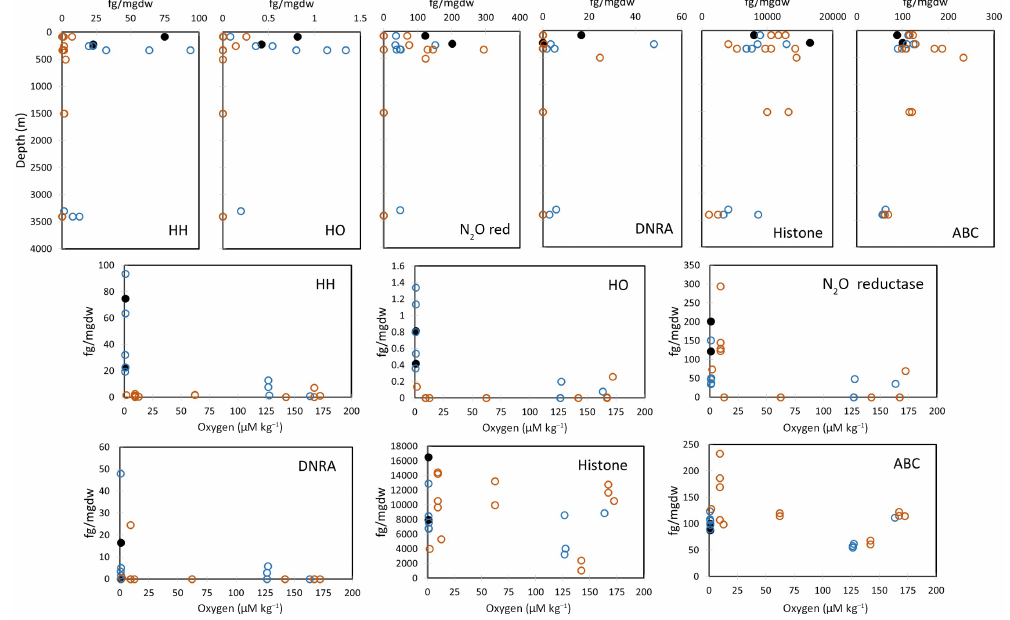
Figure 6. Target peptide quantifications. The upper row shows peptide quantifications as a function of depth, and the lower middle panels as a function of oxygen. HH combines data from 10 peptides specific to three forms of the anammox-specific enzyme hydrazine hydrolase. HO shows results from four peptides specific to the anammox enzyme hydroxylamine/hydrazine oxidoreductase. Three peptides specific to N 2 O reductase, the enzyme that catalyzes the final step of denitrification, were quantified. DNRA denotes three peptides specific to cytochrome c nitrite reductase (nrfA), a key enzyme in dissimilatory nitrate reduction to ammonium. Histone identifies two peptides specific to the eukaryote-specific H4 tetramer. ABC identifies two peptides specific to the general class of ABC transporter proteins commonly found in active (living) bacteria. (Color scheme for symbols same as in Fig.